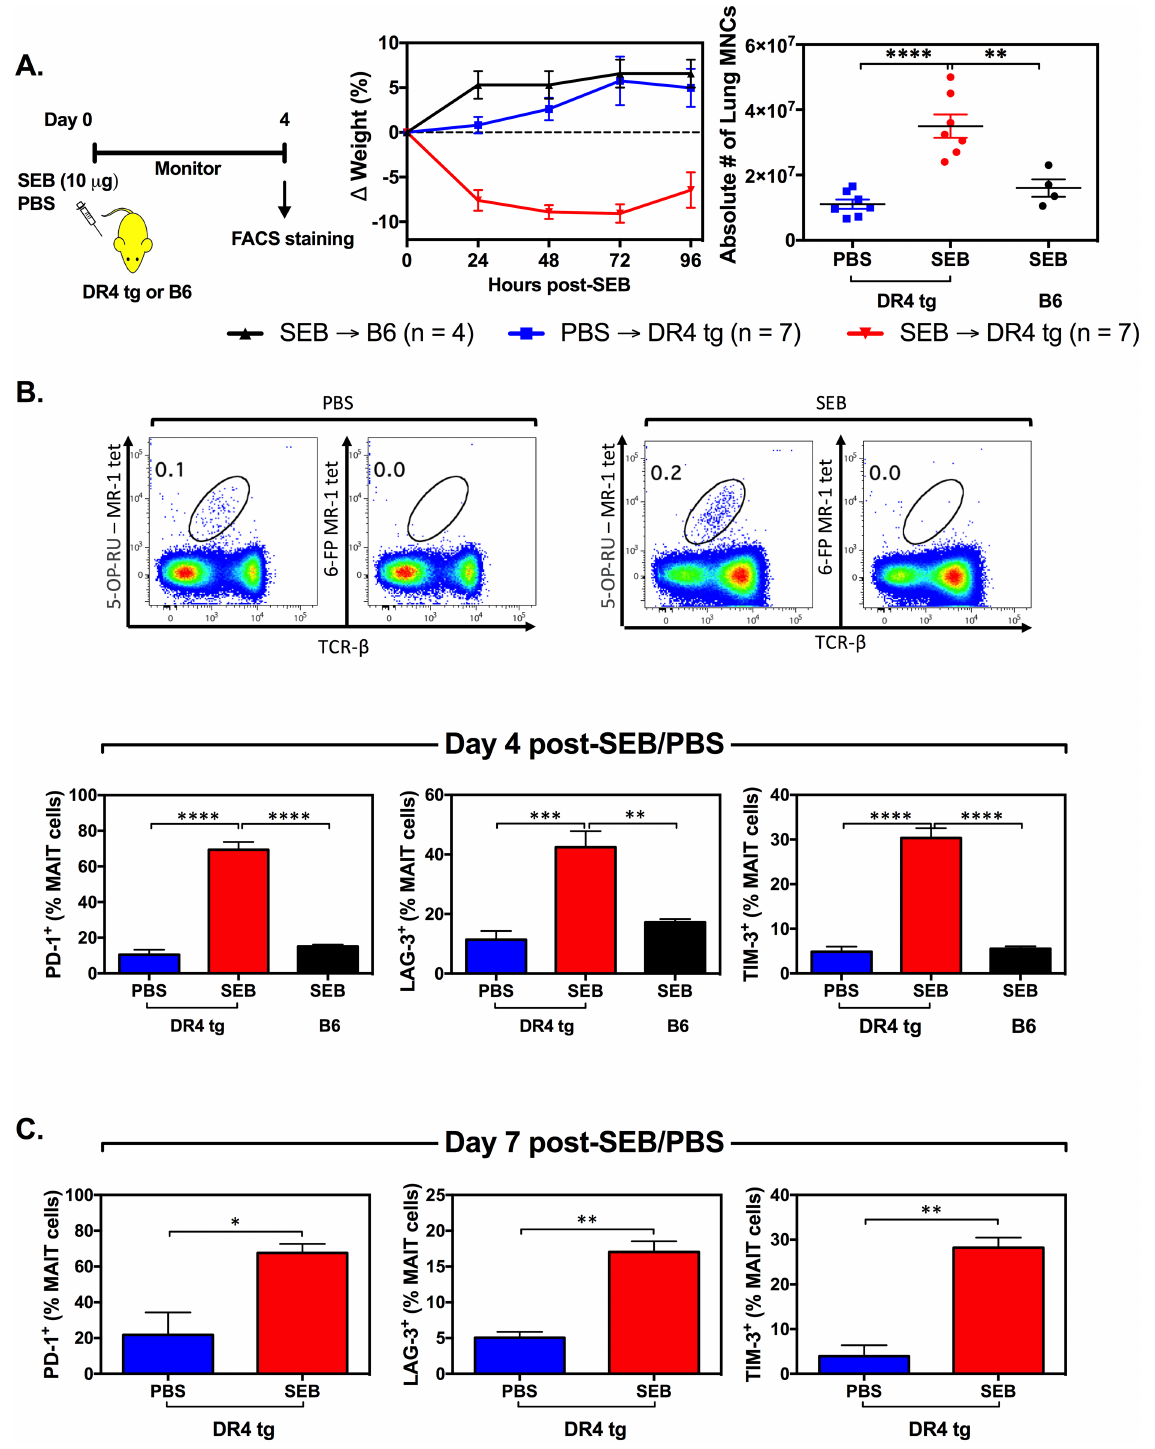
Fig 9. In vivo exposureto staphylococcal enterotoxin B (SEB) causes weight loss, non-parenchymal lung mononuclear hypercellularity, and mucosa-associated invariant T (MAIT) cell anergy in DR4-transgenic (DR4 tg) mice. Wild-type B6 and DR4 tg mice ( n = 4 or n = 7 as indicated) were injected intraperitoneally(i.p.) with 10 μ gSEB or with PBS and monitoredfor weight loss ( A ). On day 4 post-SEB/PBS injection, mice were euthanized, and total non-parenchymal lung mononuclear cells (MNCs)